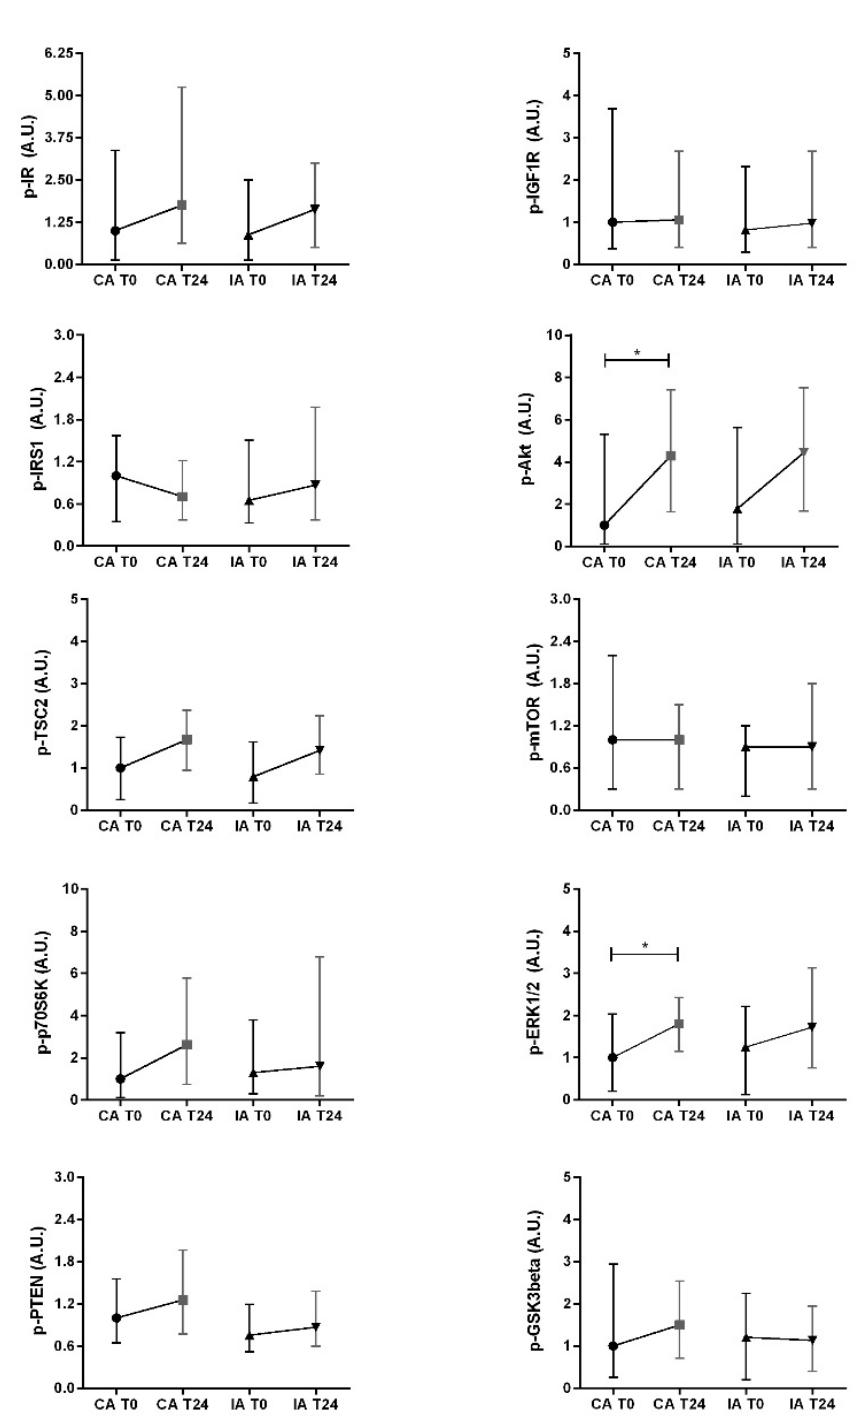
Figure 4. Main protein phosphorylation levels in insulin/IGF-1 signal transduction in esophageal